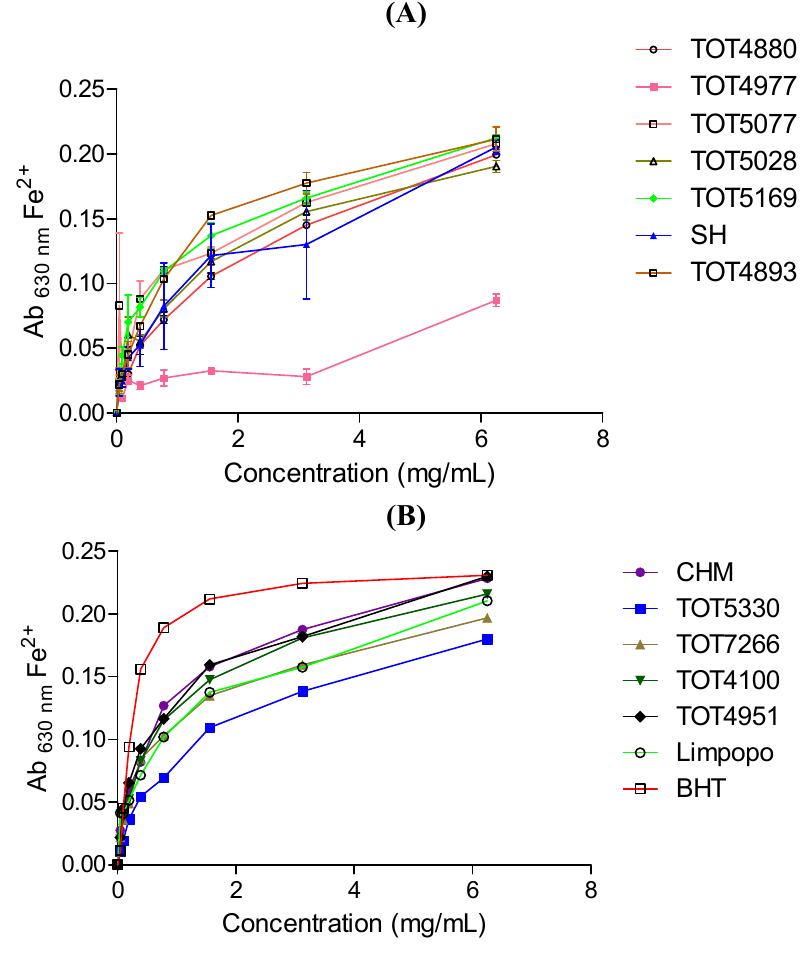
Figure 1. Ferric reducing activity of thirteen Moringa oleifera cultivars introduced from different geographical locations around the world. BHT- butylated hydroxytoluene. Increase in absorbance of the reaction mixture indicates the increase in reducing